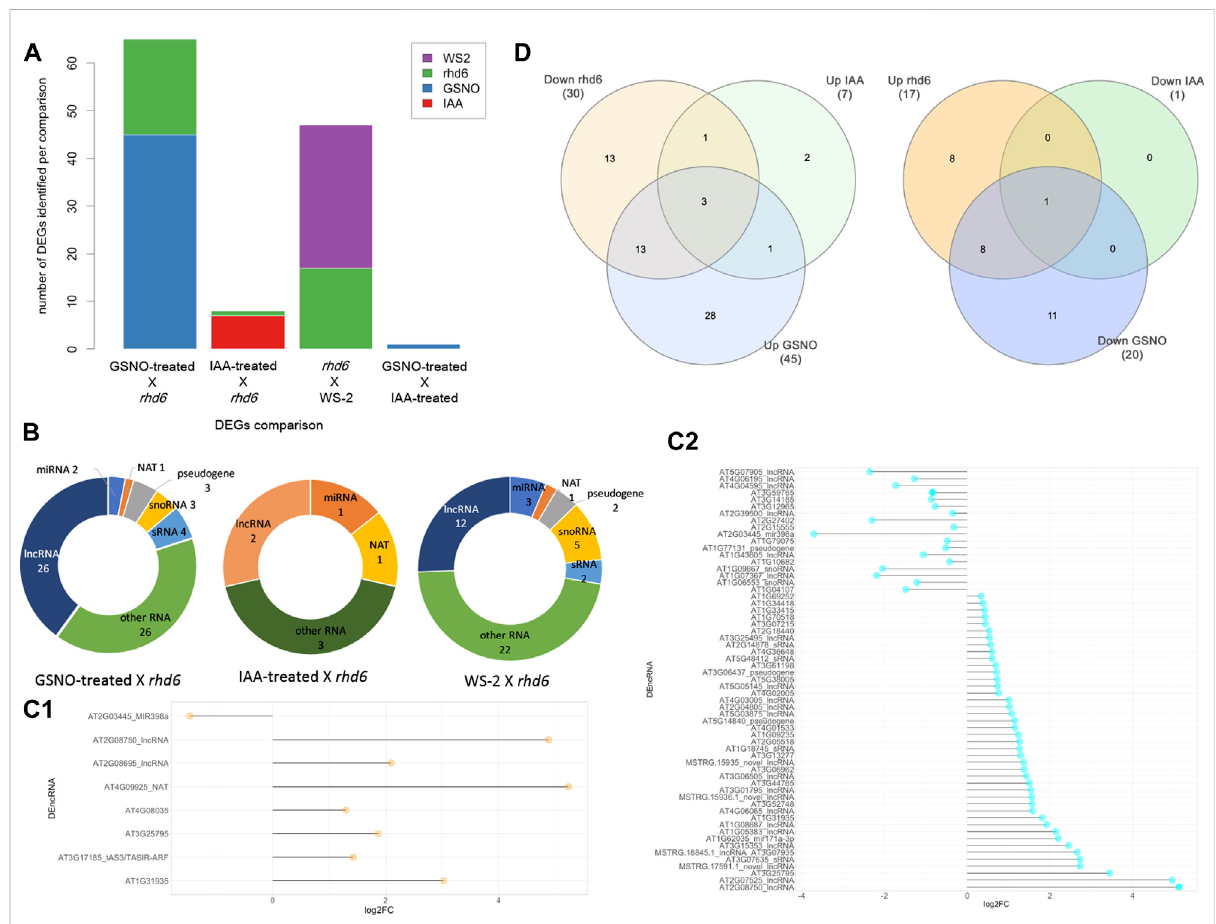
Differentially expressed gene (DEG) distribution of the four independent and paired comparisons performed. (A) Number of upregulated DEGs identi fi edinthecomparisons:GSNO-treated rhd6 vs.untreated rhd6 ,IAA-treated rhd6 vs.untreated rhd6 ,GSNO-treated rhd6 vs. IAA-treated rhd6 , and WS-2 vs. untreated rhd6 (FDR < 0.05). (B) Noncoding RNA type distribution in each comparison. GSNO-treated rhd6 vs. IAA-treated rhd6 comparison isnot shown due to thefewDEGsfound. (C1) Expressionvalues detected for DEGs inIAA-treated rhd6 vs. untreated rhd6 and (C2) GSNO-treated rhd6 vs.untreated rhd6 comparisons.The x -axisshowsthelog2FCvalues,andpositivevaluesforupregulatedandnegativevaluesfor downregulated for IAA and GSNO treatments, respectively. The y -axis shows the DEGs names. (D) Left: union of DEGs identi fi ed downregulated in untreated rhd6 mutants, and upregulated in IAA and GSNO treatments, revealing genes activated by each treatment. Right: union of DEGs identi fi ed upregulated in untreated rhd6 mutants, and downregulated in IAA and GSNO treatments, revealing genes deactivated by each